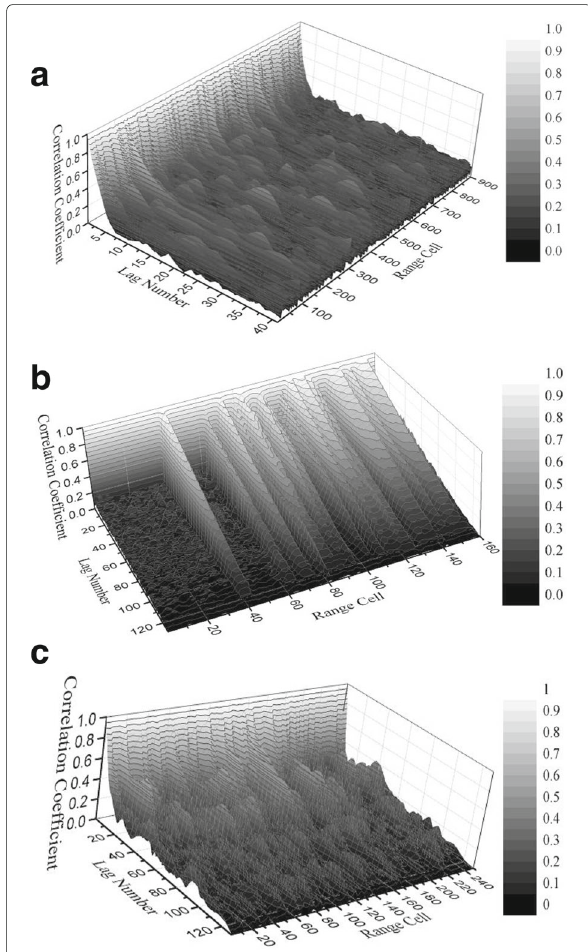
Fig. 2 Autocorrelation function of the recorded data samples: a Sea clutter. b target 1. c target 2